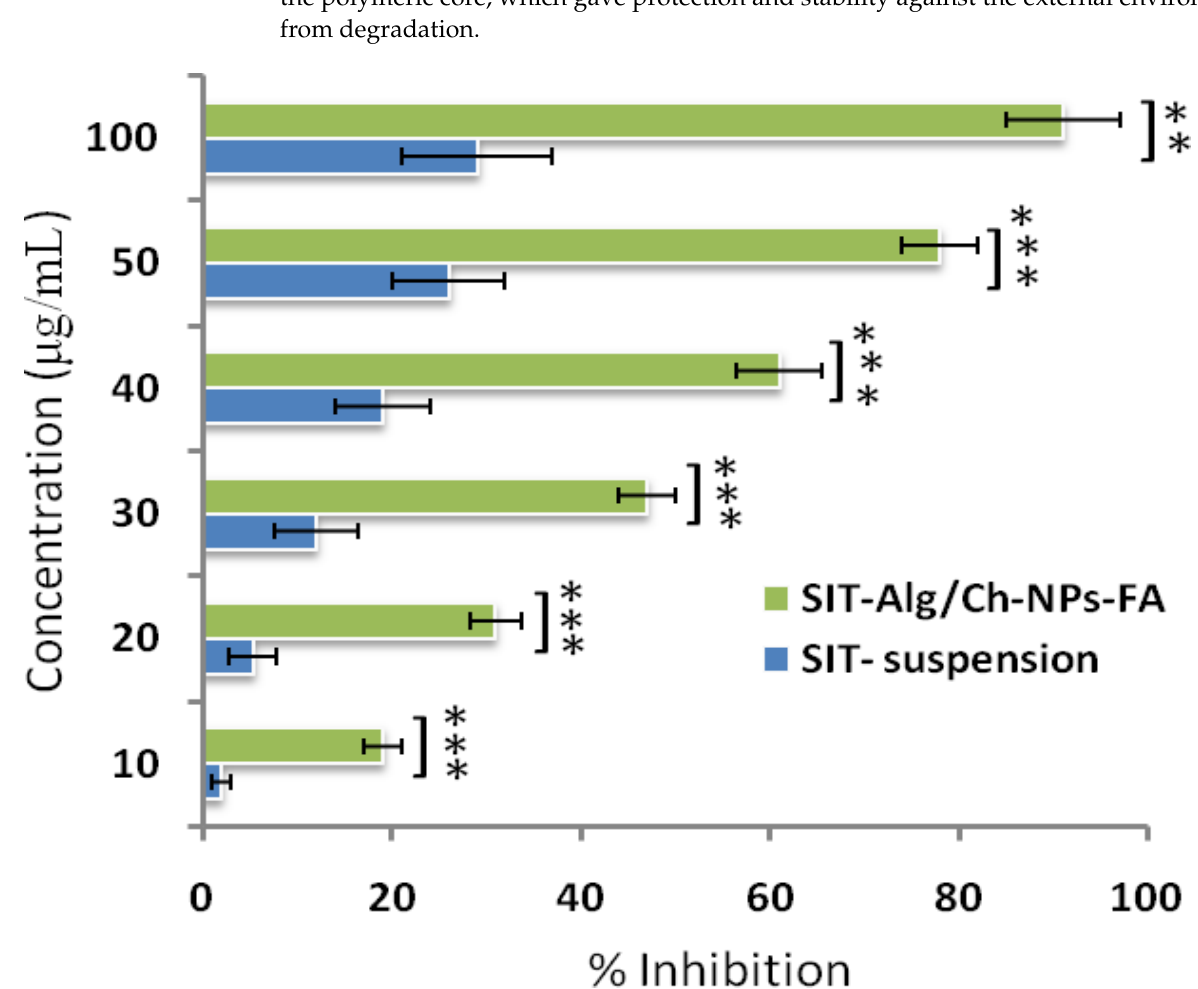
Figure 9. The antioxidant activity by DPPH assay of Alg/Ch-NPs-FA in comparison with β -SIT-suspension. Data expressed as mean ± SD ( n =3). Level of significance (*** p < 0.001), highly significant when compared with β -SITsuspension.